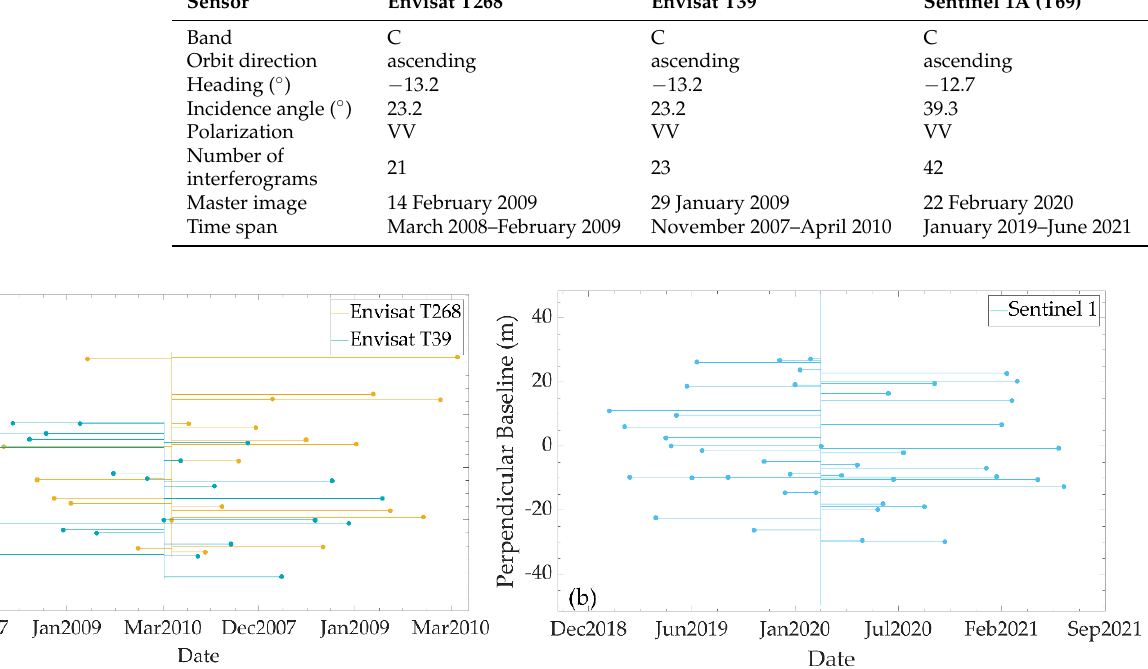
Figure 3. Space-time baseline distributions of the interferograms from the three sets of SAR